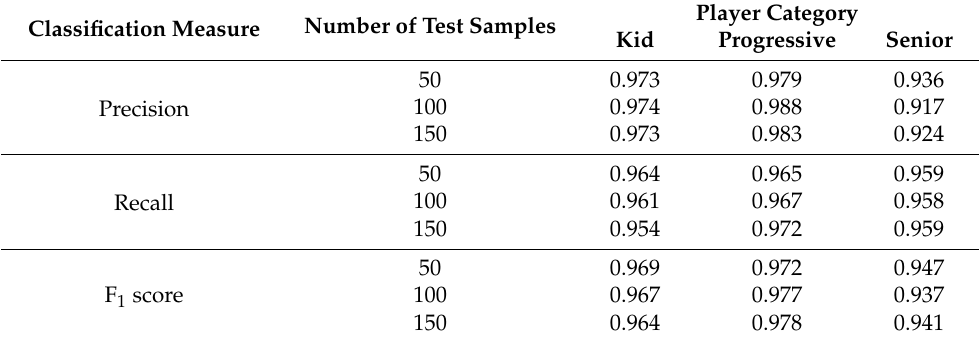
Table 5. Player classification results for the NN 2 (trained with 300